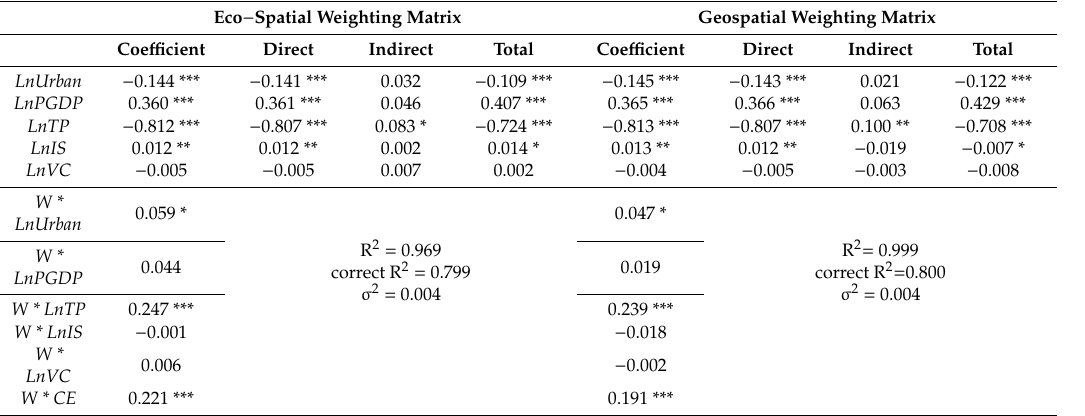
Table 3. Estimation and test results based on the spatial Durbin model (SDM) for the driving factors of CO 2eq emissions in Inner Mongolia. Eco − Spatial Weighting Matrix Geospatial Weighting Matrix Coe ffi cient Direct Indirect Total Coe ffi